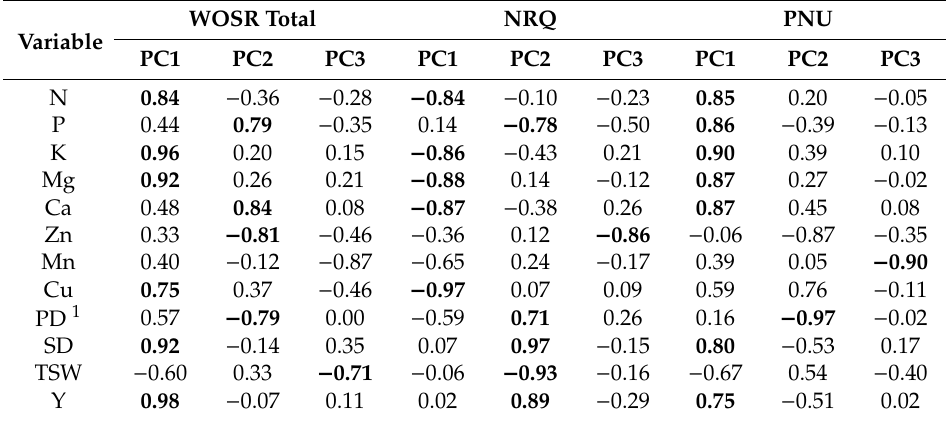
Table A3. Spearman correlation matrix between nutrient accumulation, yield components and PCA factors. Variable